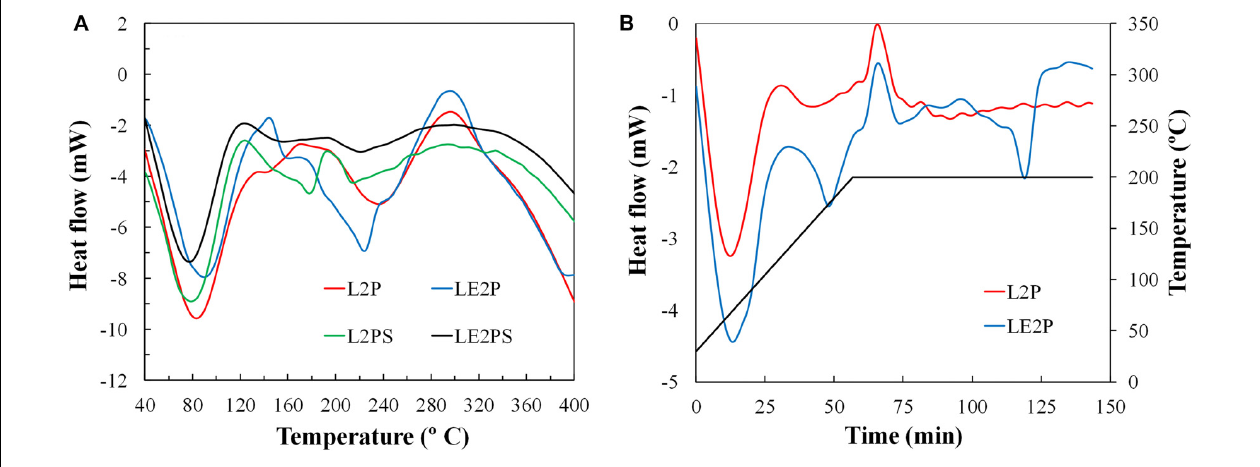
FIGURE 5 | (A) DSC curves during pyrolysis of different lignin-derived samples and (B) DSC curves during treatment of L2P and LE2P with air at 200 ◦ C.